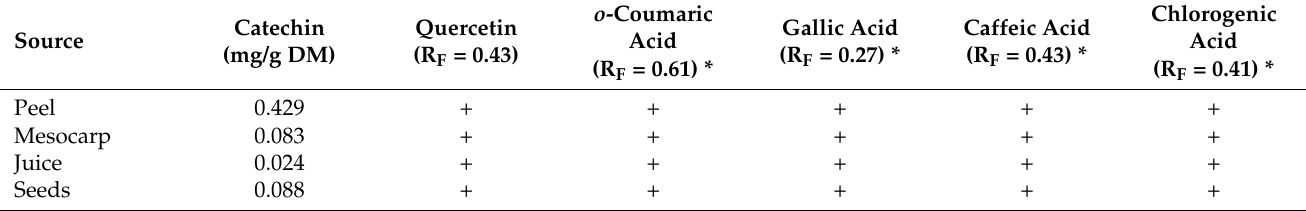
Table 5. The concentration of catechin and the presence (+) of phenolic compounds in the dry extracts prepared with 70%